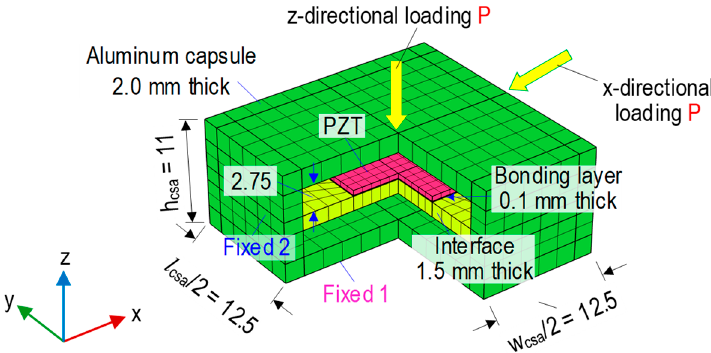
Figure 7. FE model of CSA under compression (dimension in mm).